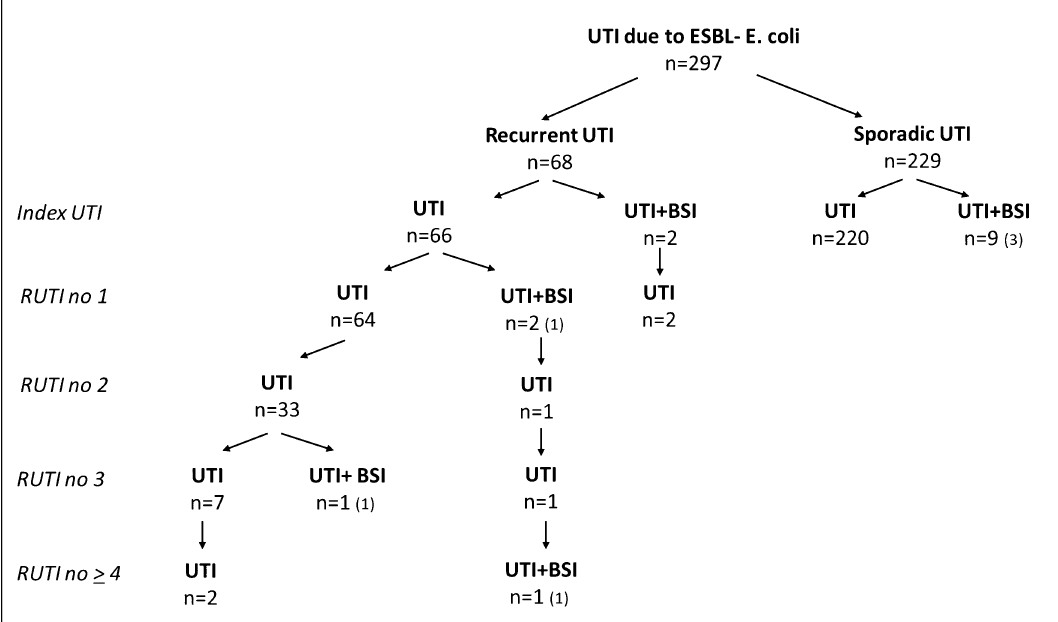
Figure 1. Number of patients with sporadic urinary tract infection (UTI) or recurrent UTI (RUTI) within one year after an index UTI due to ESBL- E. coli . All episodes are caused by ESBL- E. coli . Number of patients with concomitant bacteraemia (BSI) at each UTI episode are given and numbers within brackets are patients infected with ST131 clade C2.